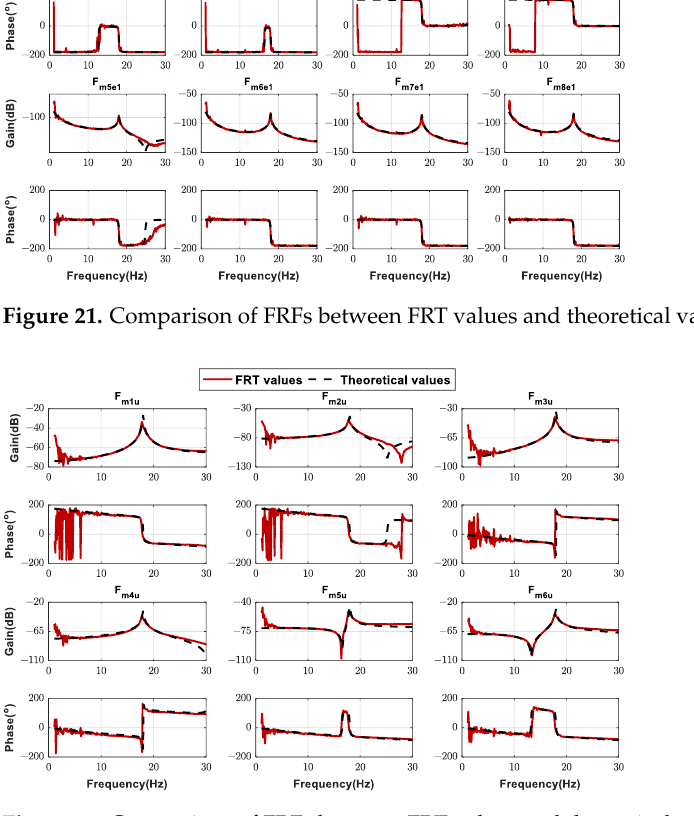
Figure 22. Comparison of FRFs between FRT values and theoretical values: F mu .